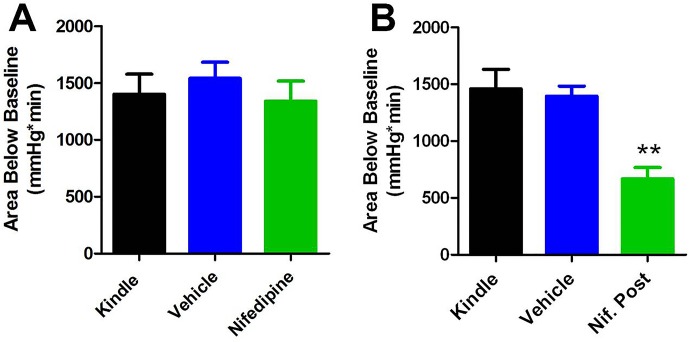
Comparing area below baseline analyses with pre- and post-administration of nifedipine.(A) Pre-administration of nifedipine had no effect on area below baseline. (B) Post-administration of nifedipine significantly reduced the area below baseline (p<0.01).